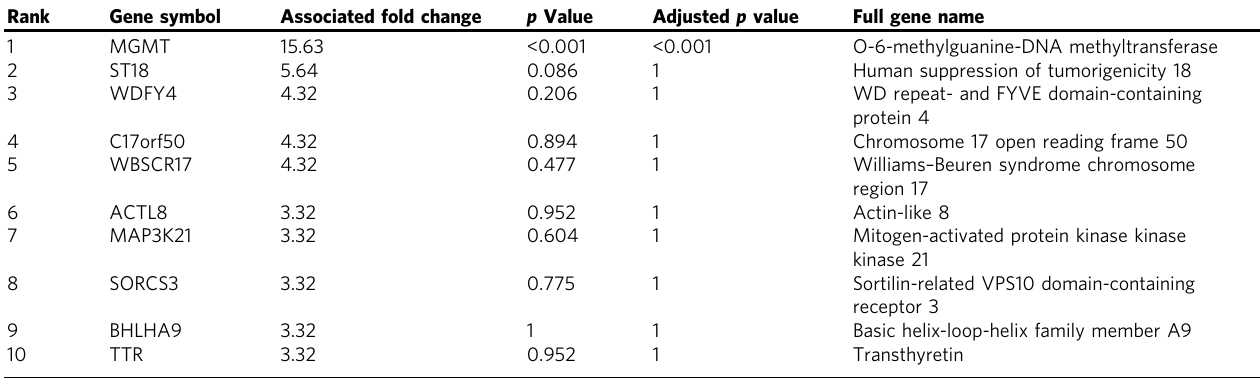
the table. The p value and adjusted p value are also